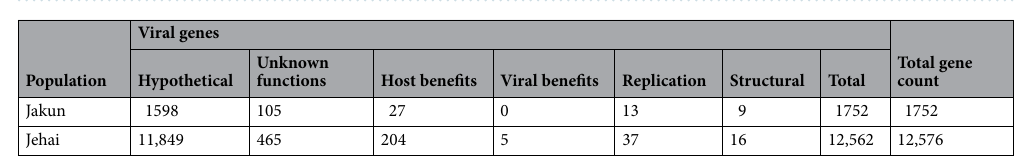
Table 1. Functional categories of genes among the two Orang Asli